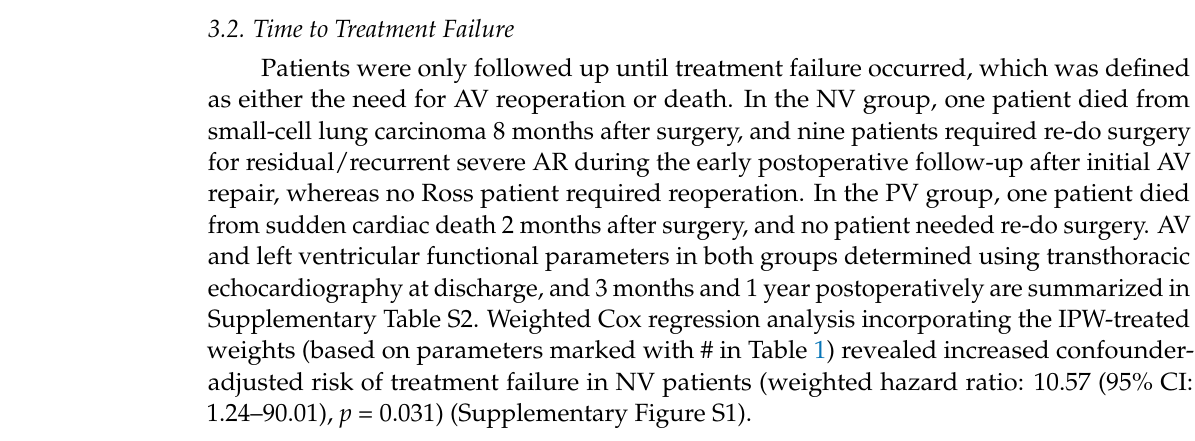
Supplementary Table S2. Weighted Cox regression analysis incorporating the IPW-treated weights (based on parameters marked with # in Table 1) revealed increased confounder- adjusted risk of treatment failure in NV patients (weighted hazard ratio: 10.57 (95%